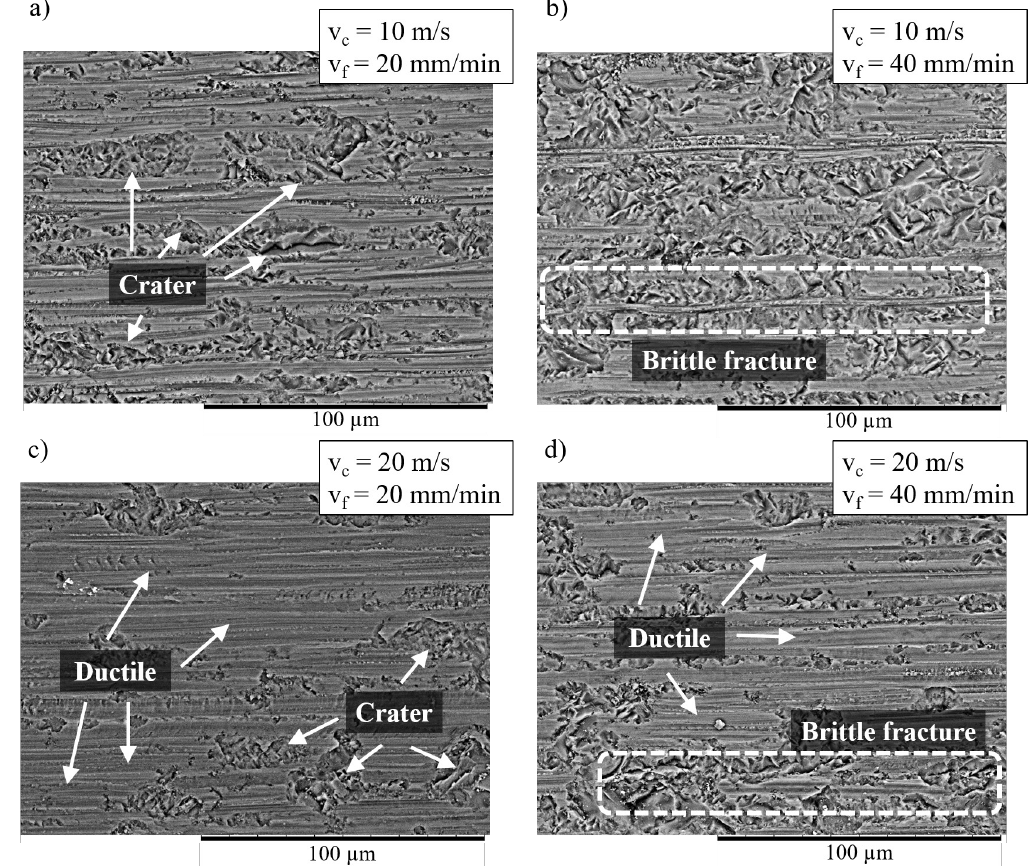
Figure 6. Morphology of sawn surface of mono-Si specimens cut under different cutting